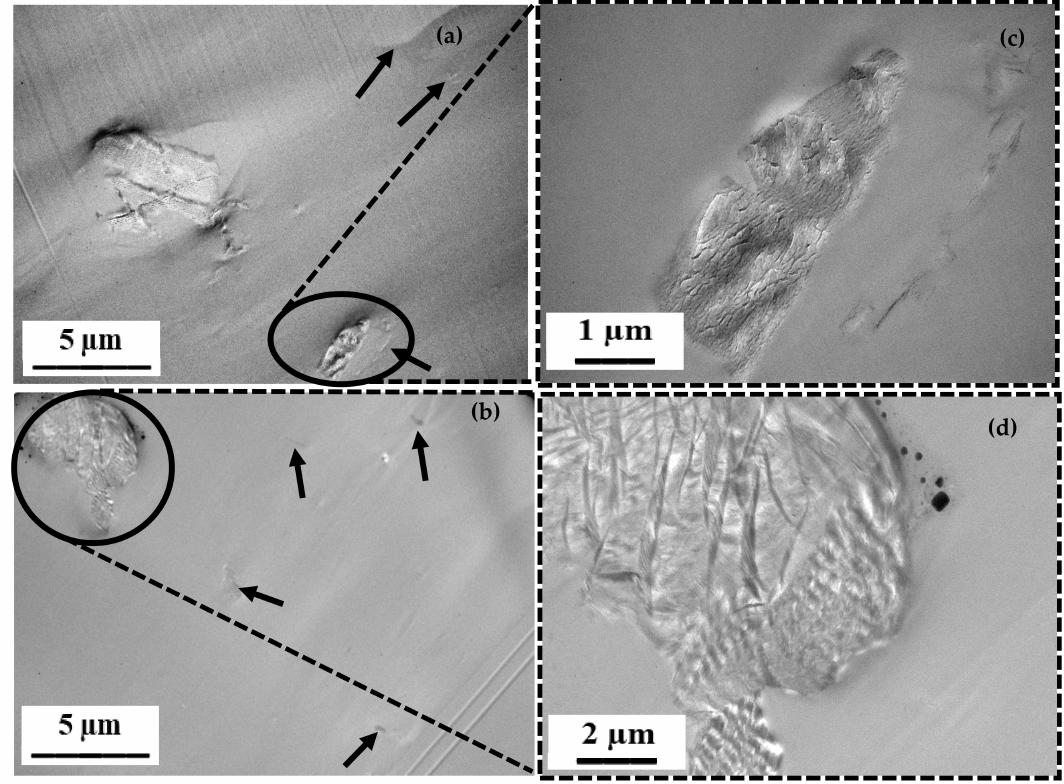
Figure 5. Typical TEM images of epoxy containing ( a ) 0.3 wt.% GO sheets and ( b ) 0.6 wt.% GO sheets at low magnification; ( c , d ) magnified images of GO sheets from image ( a , b ),